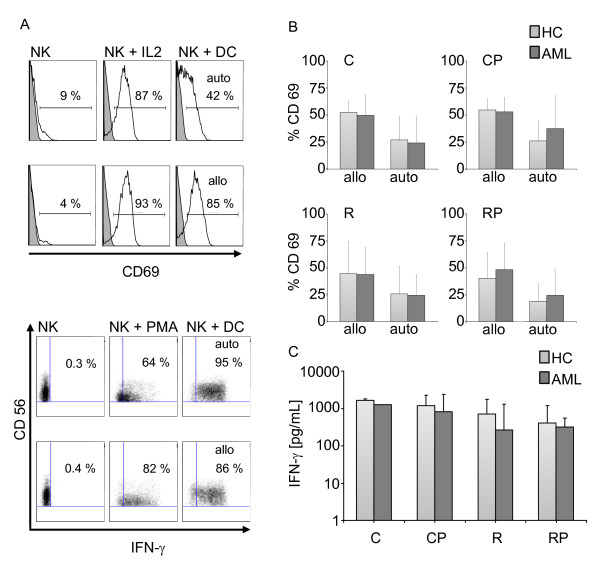
Activation of NK cells by DCs. Allogeneic and autologous non-adherent PBMCs were cocultured with DCs at a ratio of 10:1 for 24 h. Cells were stained for CD3, CD56, CD69 and IFN-γ expression and analyzed by flow cytometry. (A) Shown is the percentage of CD69 expression on CD3-/CD56+ gated NK cells. Representative histograms of unstimulated NK cells, IL-2 (500 IU/mL) activated NK cells, DCs + autologous NK cells (upper panel) and DCs + allogeneic NK cells (lower panel) of one AML patient are shown (cocktail R was used for DC maturation). The dot blots below show the corresponding intracellular IFN-γ staining, with PMA/ionomycin serving as a positive control. (B) Summary of the percentage of CD69 expression on CD3-/CD56+ NK cells after coculture with allogeneic and autologous NK cells from HC and AML patients. (C) Production of IFN-γ after coculture of DCs and isolated NK cells was assessed by ELISA. DCs were generated and cocultured with allogeneic NK cells at a ratio of 1:10 for 24 h. Supernatant was analyzed by standard ELISA for IFN-γ. The comparison of HC and AML patients is shown using the four different maturation cocktails. As a positive control NK cells were stimulated with IL-2.